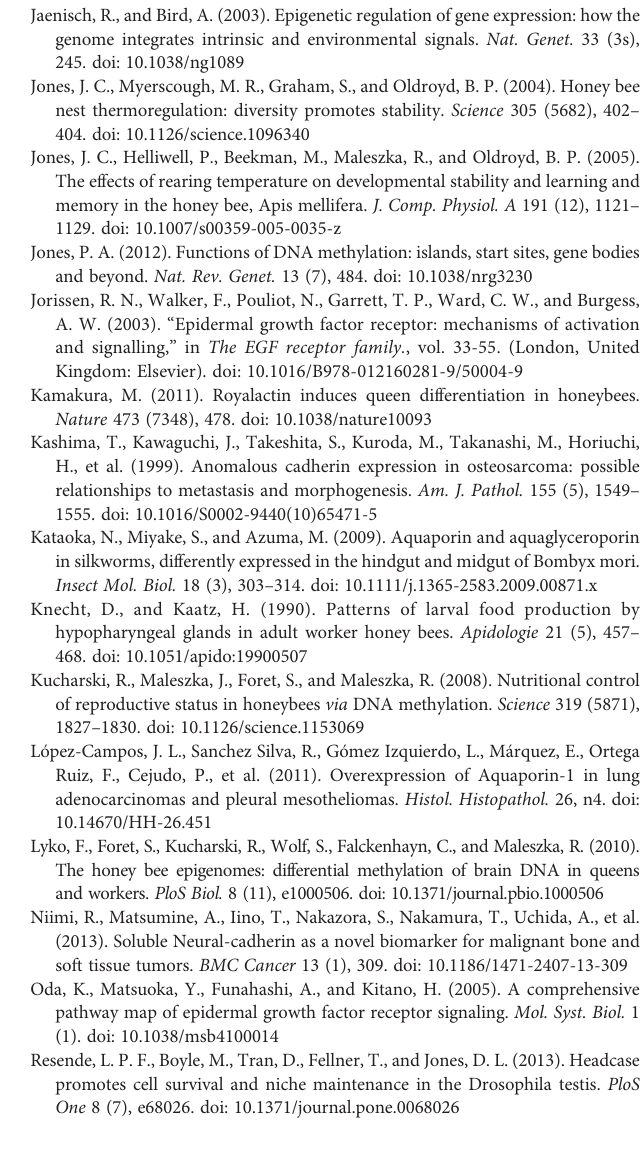
FIGURE S1 | Global distributing pattern of methylation degrees for various types of methylations. WB, Winter Bee. SB, Spring Bee. The red, blue and green colors